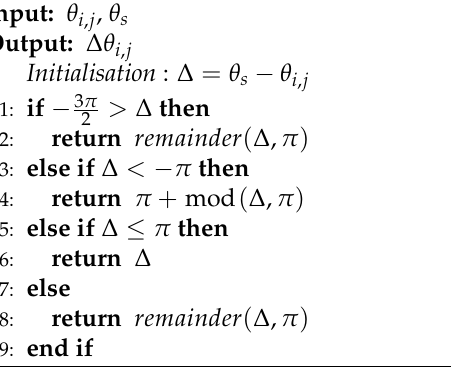
Algorithm 1 Normalized azimuth subtraction.